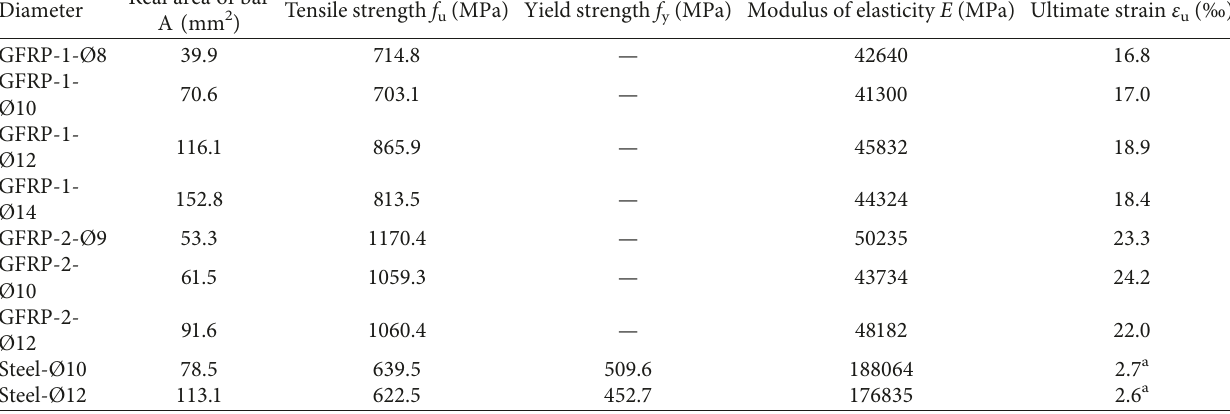
Table 2: Mechanical and deformation characteristics of GFRP reinforcement.